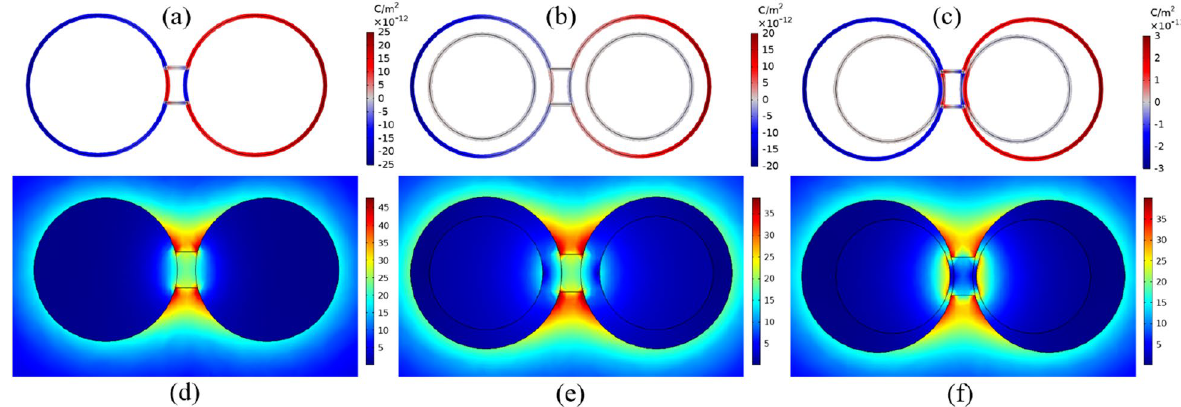
Figure 5. Top panel: Surface Charge distribution of CTP mode of ( a ) SSBD ( b ) CSBD, ( c ) NEBD. Red color represents positive charge while blue is negative. Bottom panel: E-field maps of the bridged dimer calculated at CTP. ( d ) SSBD at (cid:31) CTP = 1104 nm , ( e ) CSBD at (cid:31) CTP = 1176 nm and ( f ) NEBD at (cid:31) CTP = 1487 nm